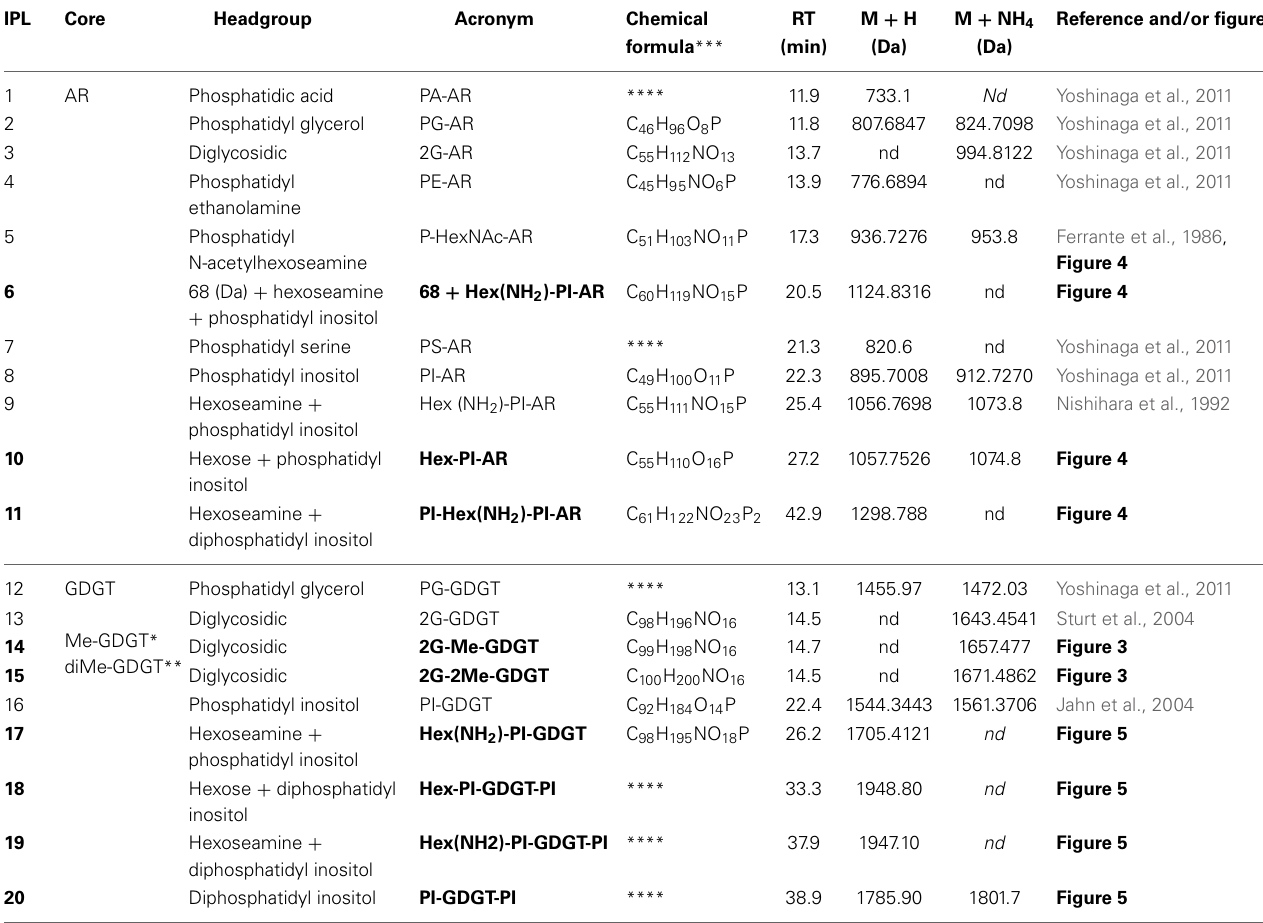
Table 2 | IPLs of T. kodakarensis . Novel IPLs are indicated in